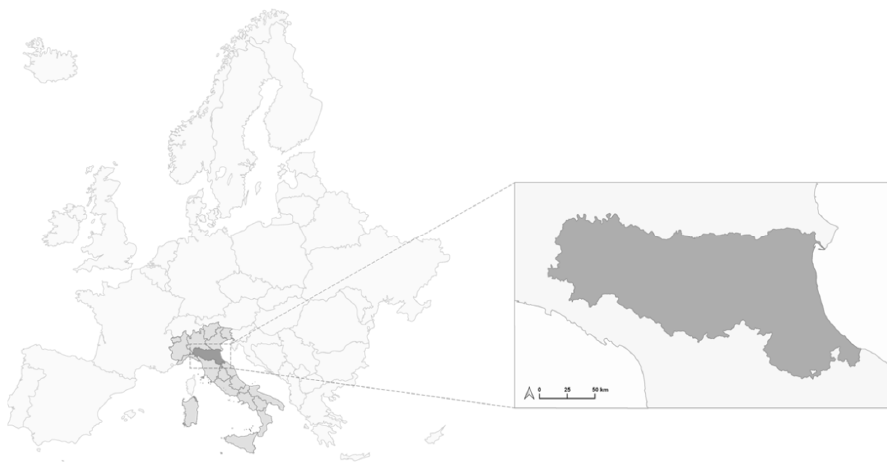
Figure 1. Study area